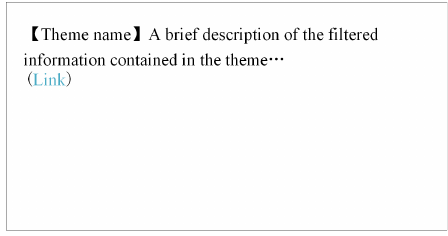
Figure 5. SMS design diagram.